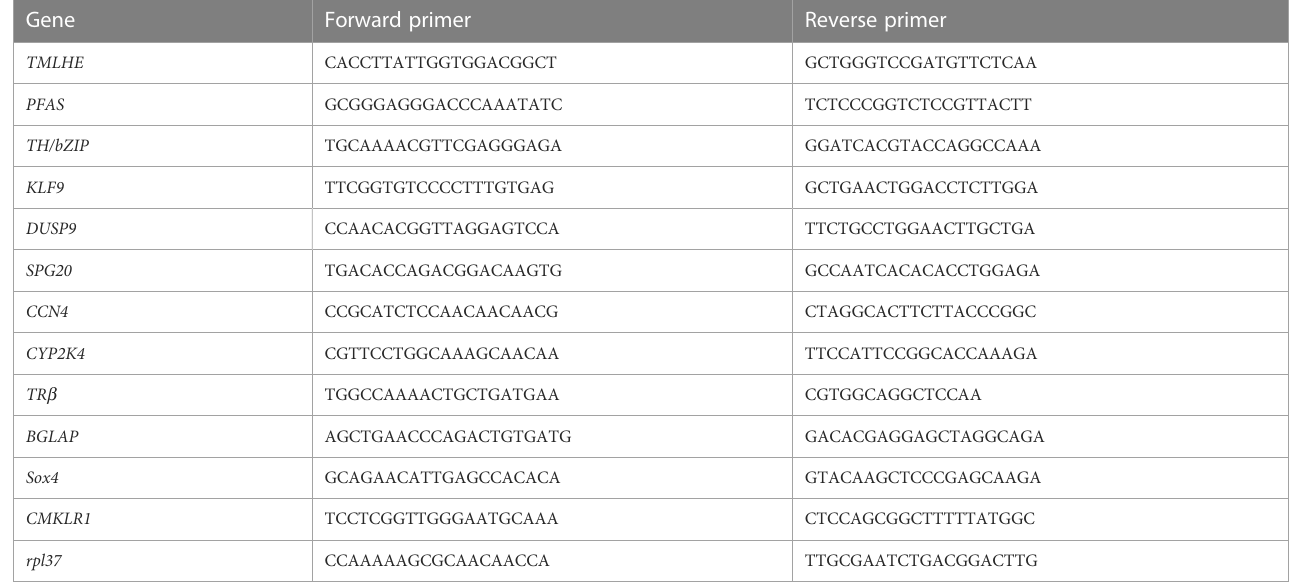
TABLE 1 Primers used in gene expression analysis by quantitative real-time PCR.